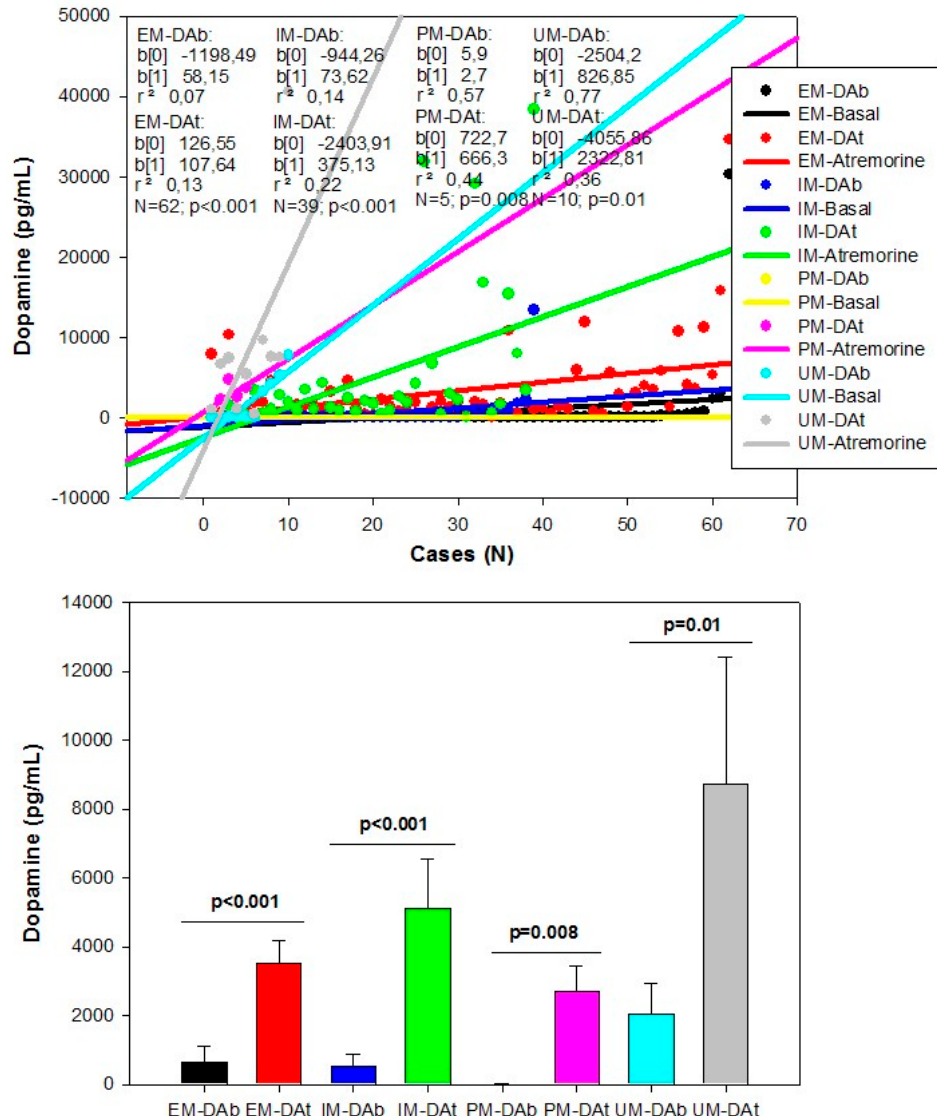
Figure 3. CYP2D6-related Atremorine-induced dopamine response. Basal (DAb) and Atremorine- induced dopamine response (DAt) in CYP2D6 extensive (EM), intermediate (IM), poor (PM), and ultra-rapid metabolizers (UM). Adapted with permission from Cacabelos et al. [17].